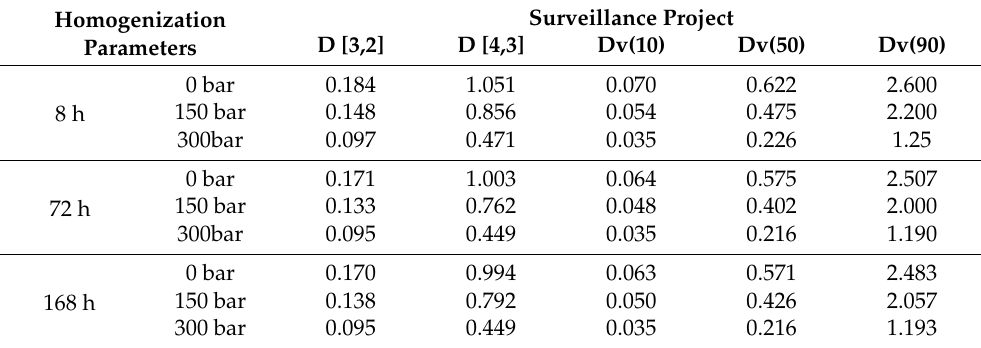
Table 5. Particle size distribution data under different storage times and homogenization pressures. Surveillance Project Homogenization D Parameters